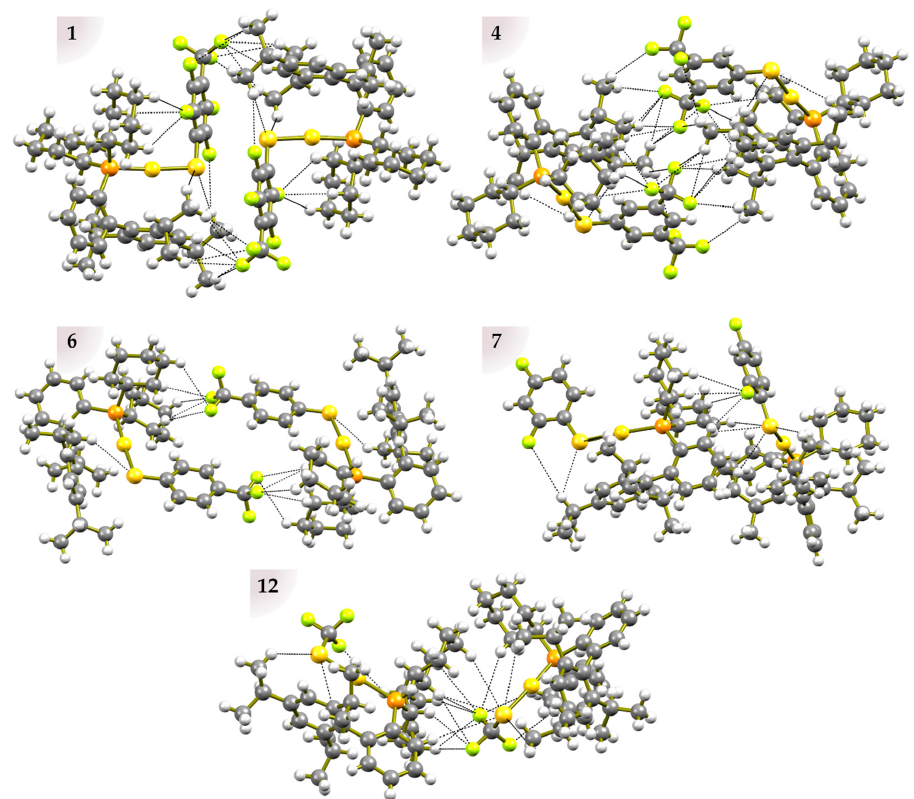
Figure 4. H-bond interactions (D–H · · · A) in the dimeric arrangements of compounds 1 , 4 , 6 , 7 , and 12 . The shown interactions present angles ∠ D–H ··· A equal or greater than 120 ◦ , distances H–A, which differ less than 0.5 Å with the sum of van der Waals radii [42], and at least three bonds of separation between D and A for intramolecular contacts.